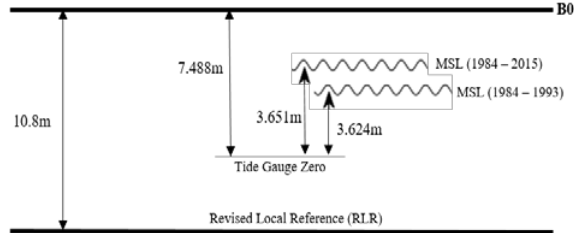
Figure 10. MSL Height Variation at Port Kelang